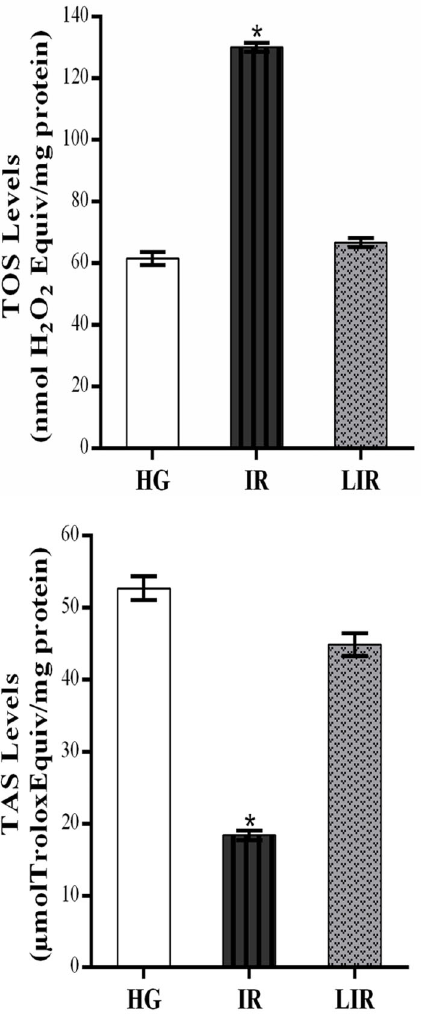
Figure 3. Blood urea nitrogen (BUN) and creatinine levels of healthy control (HG), isoniazid + rifampicin (IR), and lycopene + isoniazid + rifampicin (LIR) groups in the blood samples. Data are reported as means ± SE. *P o 0.0001 compared to HG and LIR groups (n=6) (ANOVA followed by Fisher ’ s post hoc least signi fi cant